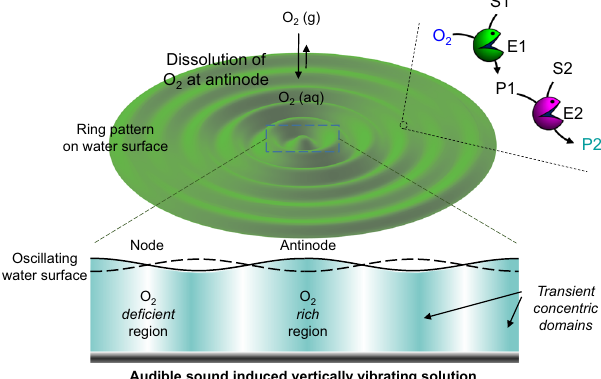
Fig. 1 Audible sound induced generation of transient domains and spatiotemporally controlled cascade reaction networks. Schematic of the audible sound induced surface standing wave and generation of corresponding concentric rings (cross-sectional view). Spatiotemporally controlled cascade reaction of substrate S1 with an oxygen responsive enzyme E1 is facilitated at the antinodal domains due to the region-speci fi c dissolution of oxygen. The fi nal product P2 is generated by the reaction of product P1 and substrate S2 with enzyme E2, which is observed as a color